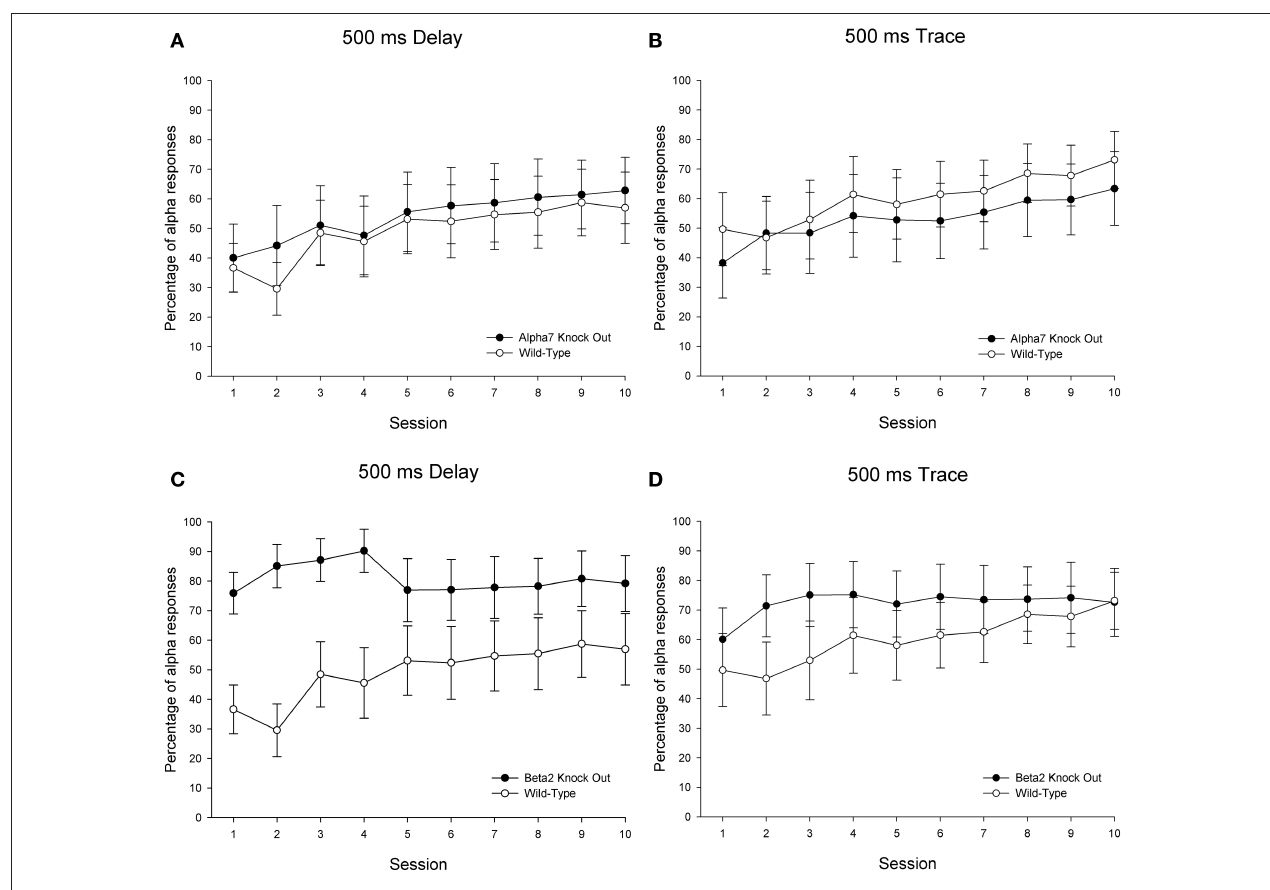
Figure 5 | Percentage of alpha responding [responses occurring within the first 60 ms of conditioned stimulus – CS – onset] over 10 sessions in the same subjects and same sessions depicted in Figures 3 and 4: Twenty-six wild-type control mice (15 in delay and 11 trained in trace), 20 α 7 KO mice (10 in delay and 10 trained in trace), and 24 β 2 KO mice (12 in